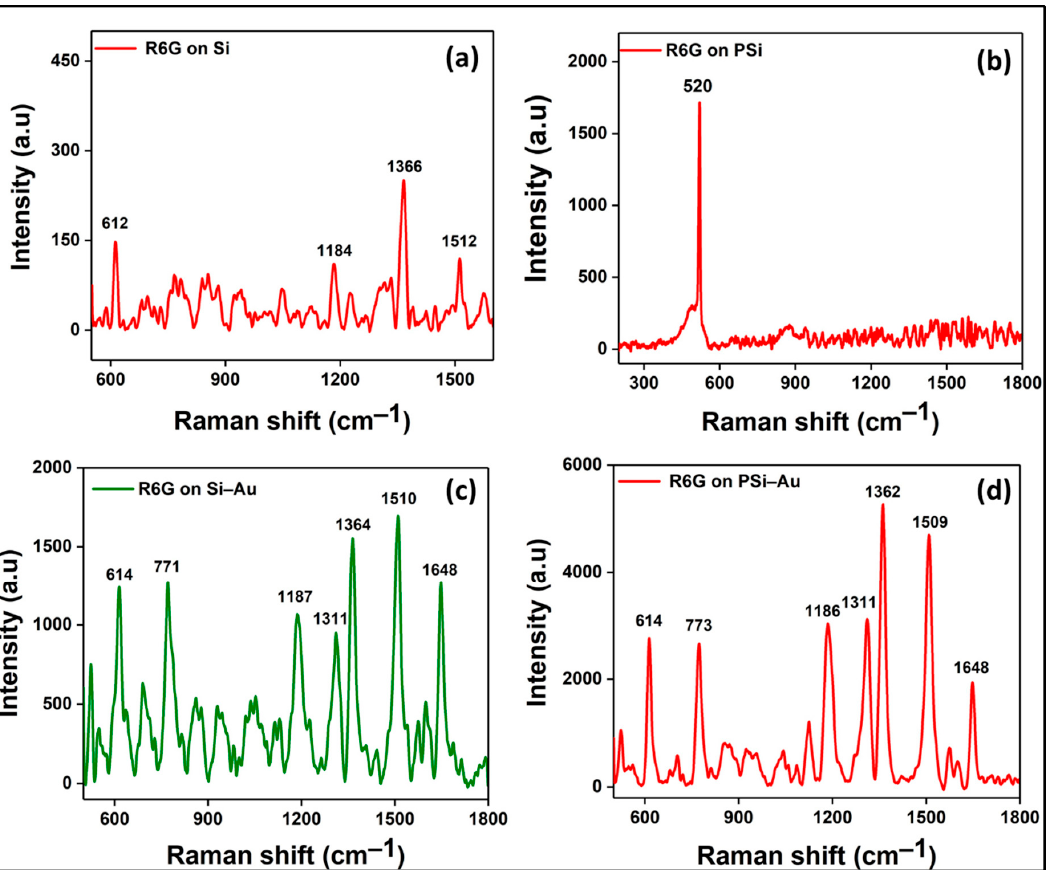
Figure 4. ( a ) Raman spectra of R6G (10 − 2 M) obtained from pure Si wafer, and ( b ) Raman spectra of R6G (10 − 6 M) on bare PSi substrate. SERS spectra of R6G (10 − 6 M) adsorbed on ( c ) Si–Au thin film and ( d ) PSi–Au thin film.